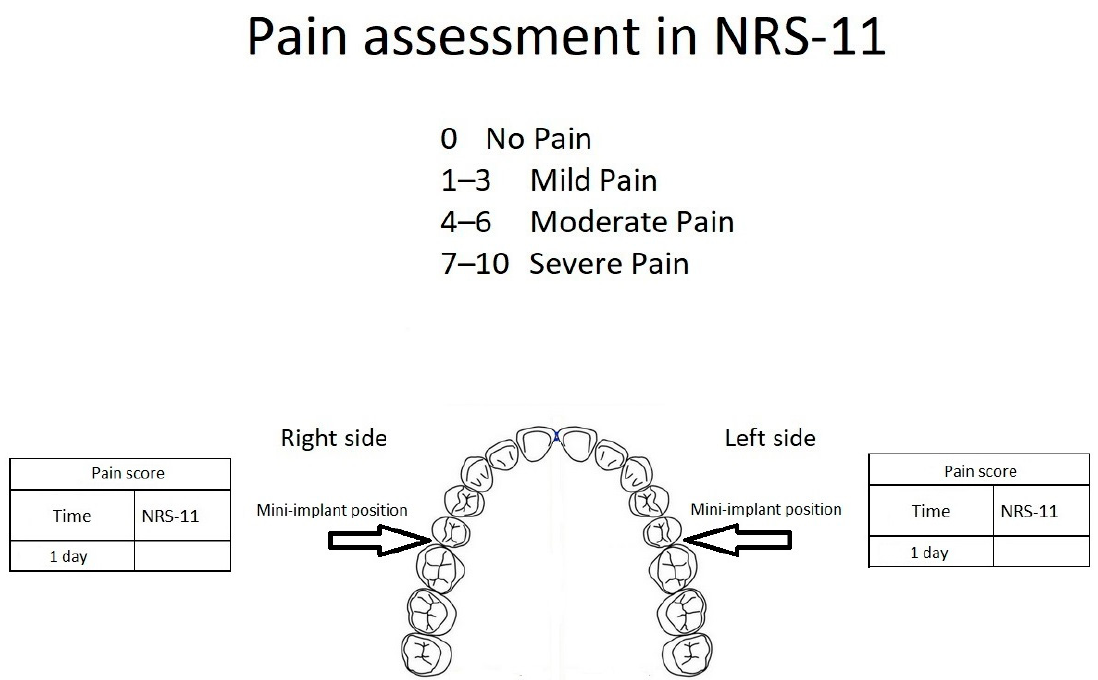
Figure 4. Pain assessment on the NRS-11 scale on both sides of the maxilla during the first day after the treatment.